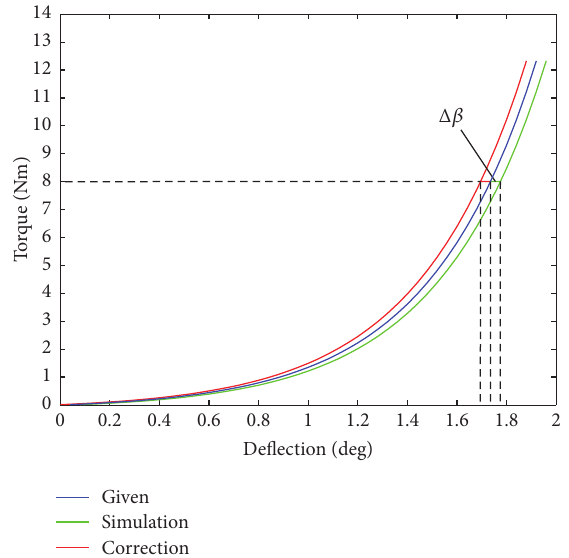
Figure 3: Errors analysis of theoretical calculation and simulation